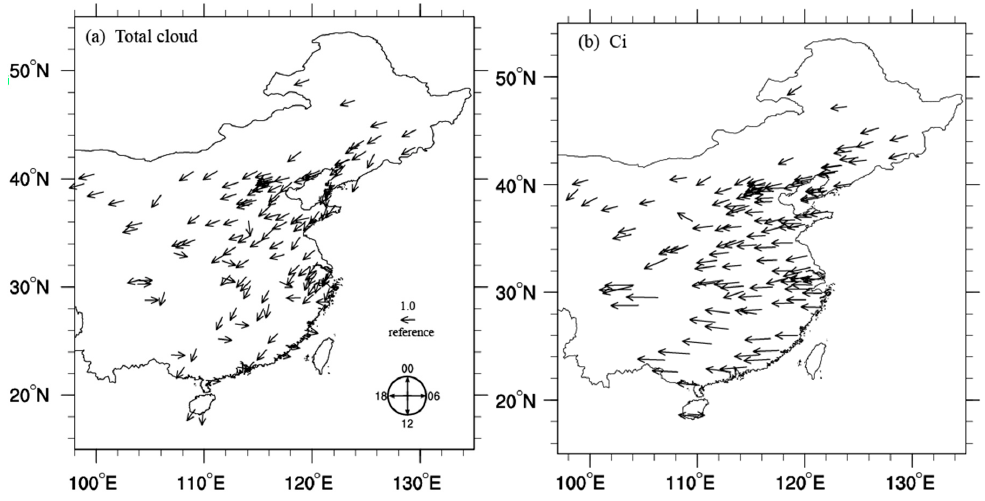
Figure 1. The diurnal variation of the occurrence frequencies (%) of various cloud types in central and east China during 1981–2011: ( a ) TC, Ac, As, ( b ) Ns, Sc, St, ( c ) Cu, Cb, Ci(the horizontal axis represents the local solar time, and the vertical axis represents the occurrence frequency of